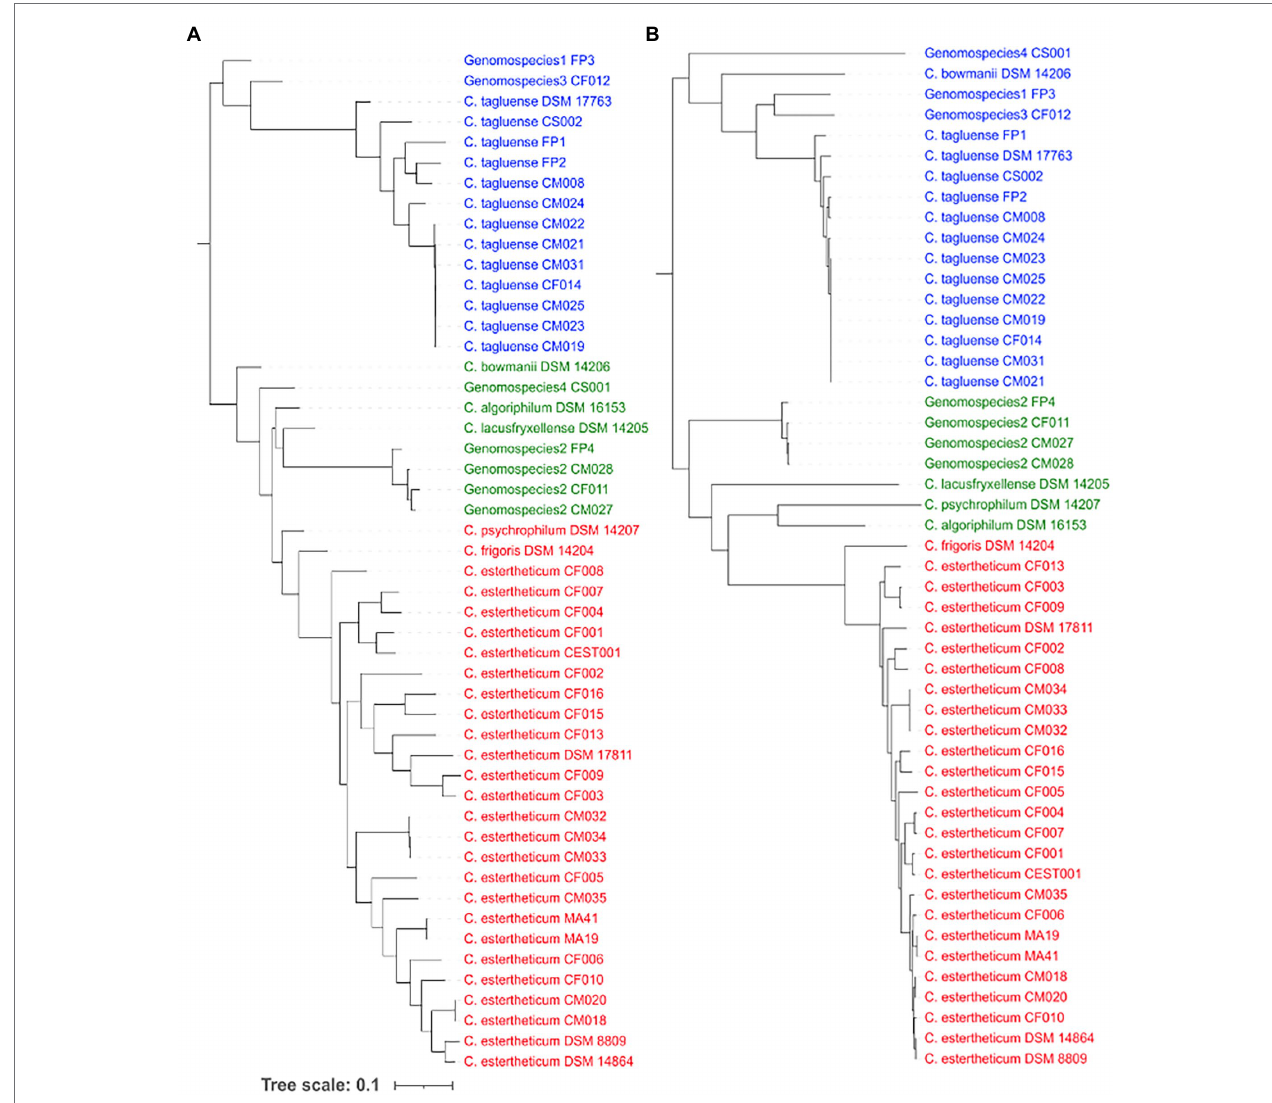
FIGURE 3 | Influence of recombination events on the population structure of CEC. The core genome-based phylogeny of CEC (A) before and (B) after the removal of recombination events and three corresponding clades from each tree are highlighted in blue, green, and red